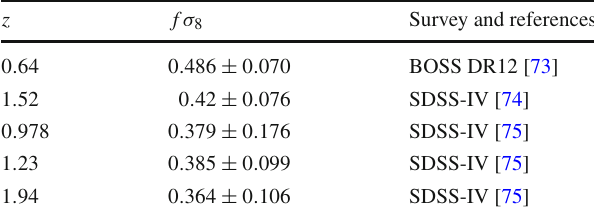
Table1 New f σ 8